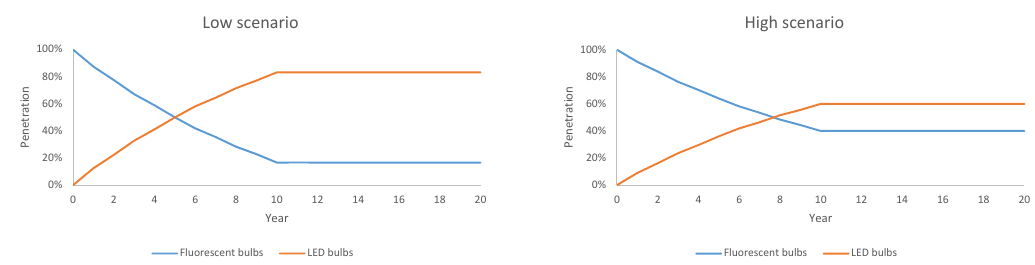
Figure 2. Installed capacity for both scenarios.